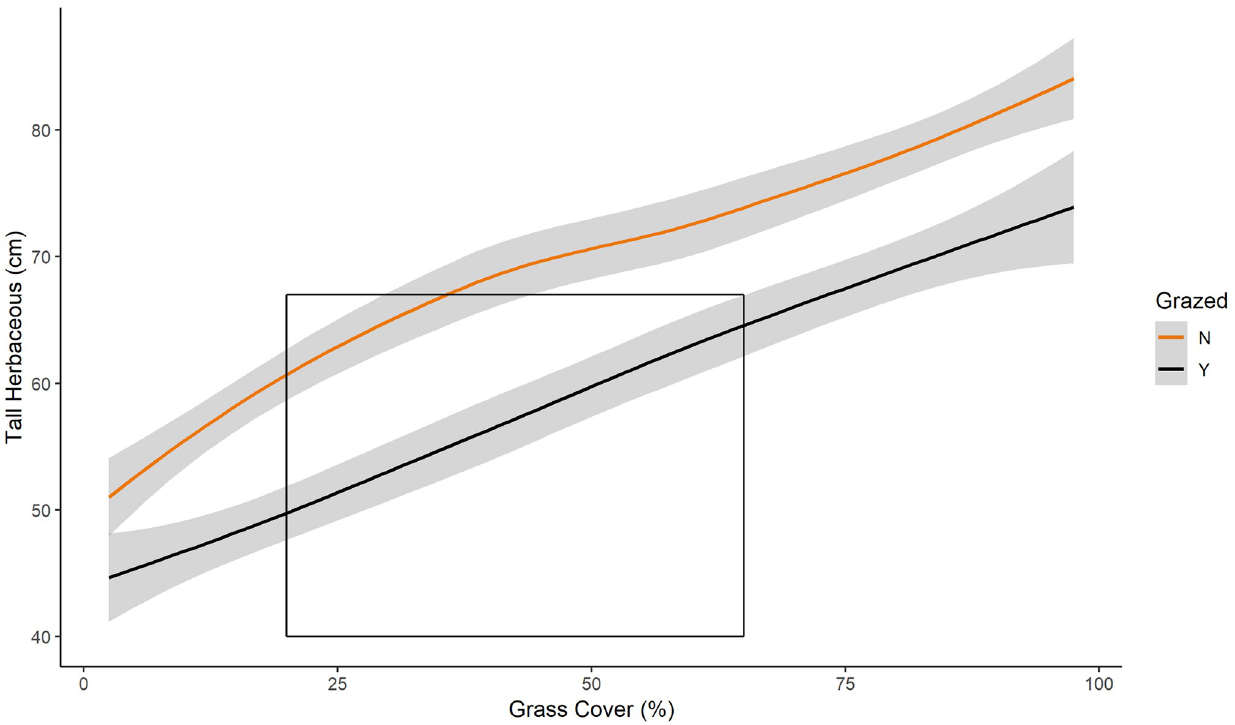
Fig 8. Vegetation height vs percent grass. Maximum height(cm) of herbaceous vegetation related to percent cover of grasses in fire-only (orange) and pyric herbivory (black) treatments at all sites from 2014 to 2016. Area within box represents the minimum and maximum recommended parameters for suitable nesting cover for prairie-chickens from primary literature. Shaded area indicates 95% confidence interval. � Regression lines and confidence intervals generated using “loess” locally-weighted smoothing